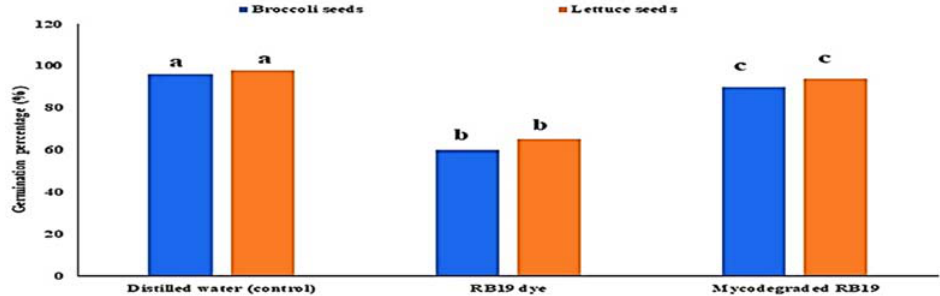
Figure 7. Effect of MG dye and its degraded metabolite products on the germination percentage (%) of broccoli ( Brassica oleracea var. italic ) and lettuce ( Lactuca sativa var. capitata ) seeds.